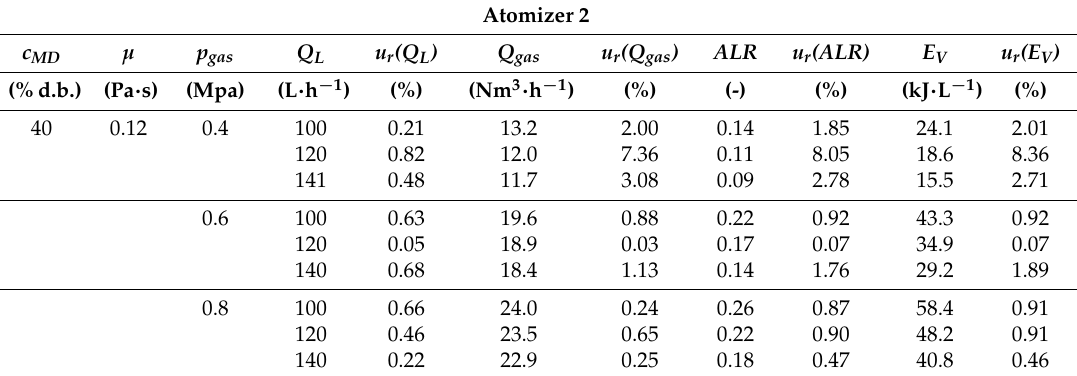
Table 5. Applied gas pressures ( p gas ) and liquid volume flow rates ( Q L ), as well as resulting gas volume flow rates ( Q gas ), air/liquid mass ratios (ALR) and volumetric energy densities ( E V ). Additionally, uncertainty values u r ( γ ) of resulting parameters Q ga s , ALR, and E V are given. Measurement values of Q gas are reported at normal conditions (273.15 K, 0.1013 MPa abs ) in normal cubic meters per hour (Nm 3 · h − 1